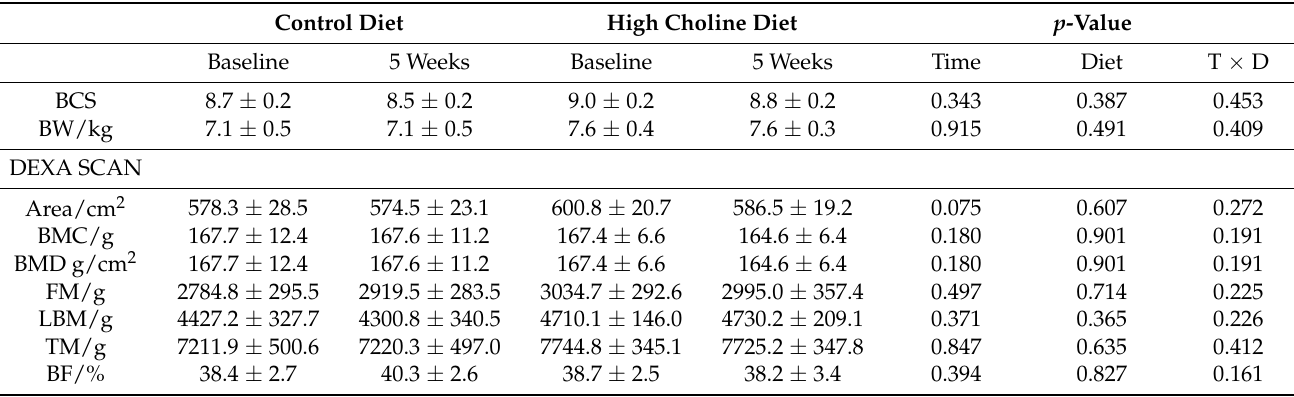
Table 2. Body weight and body composition in 12 chronically obese cats at baseline and after feeding a control food (458.7 mg choline/100g DM) ( n = 6) or a high-choline food (1895.7 mg choline/100g DM) ( n = 6) for 5 weeks.